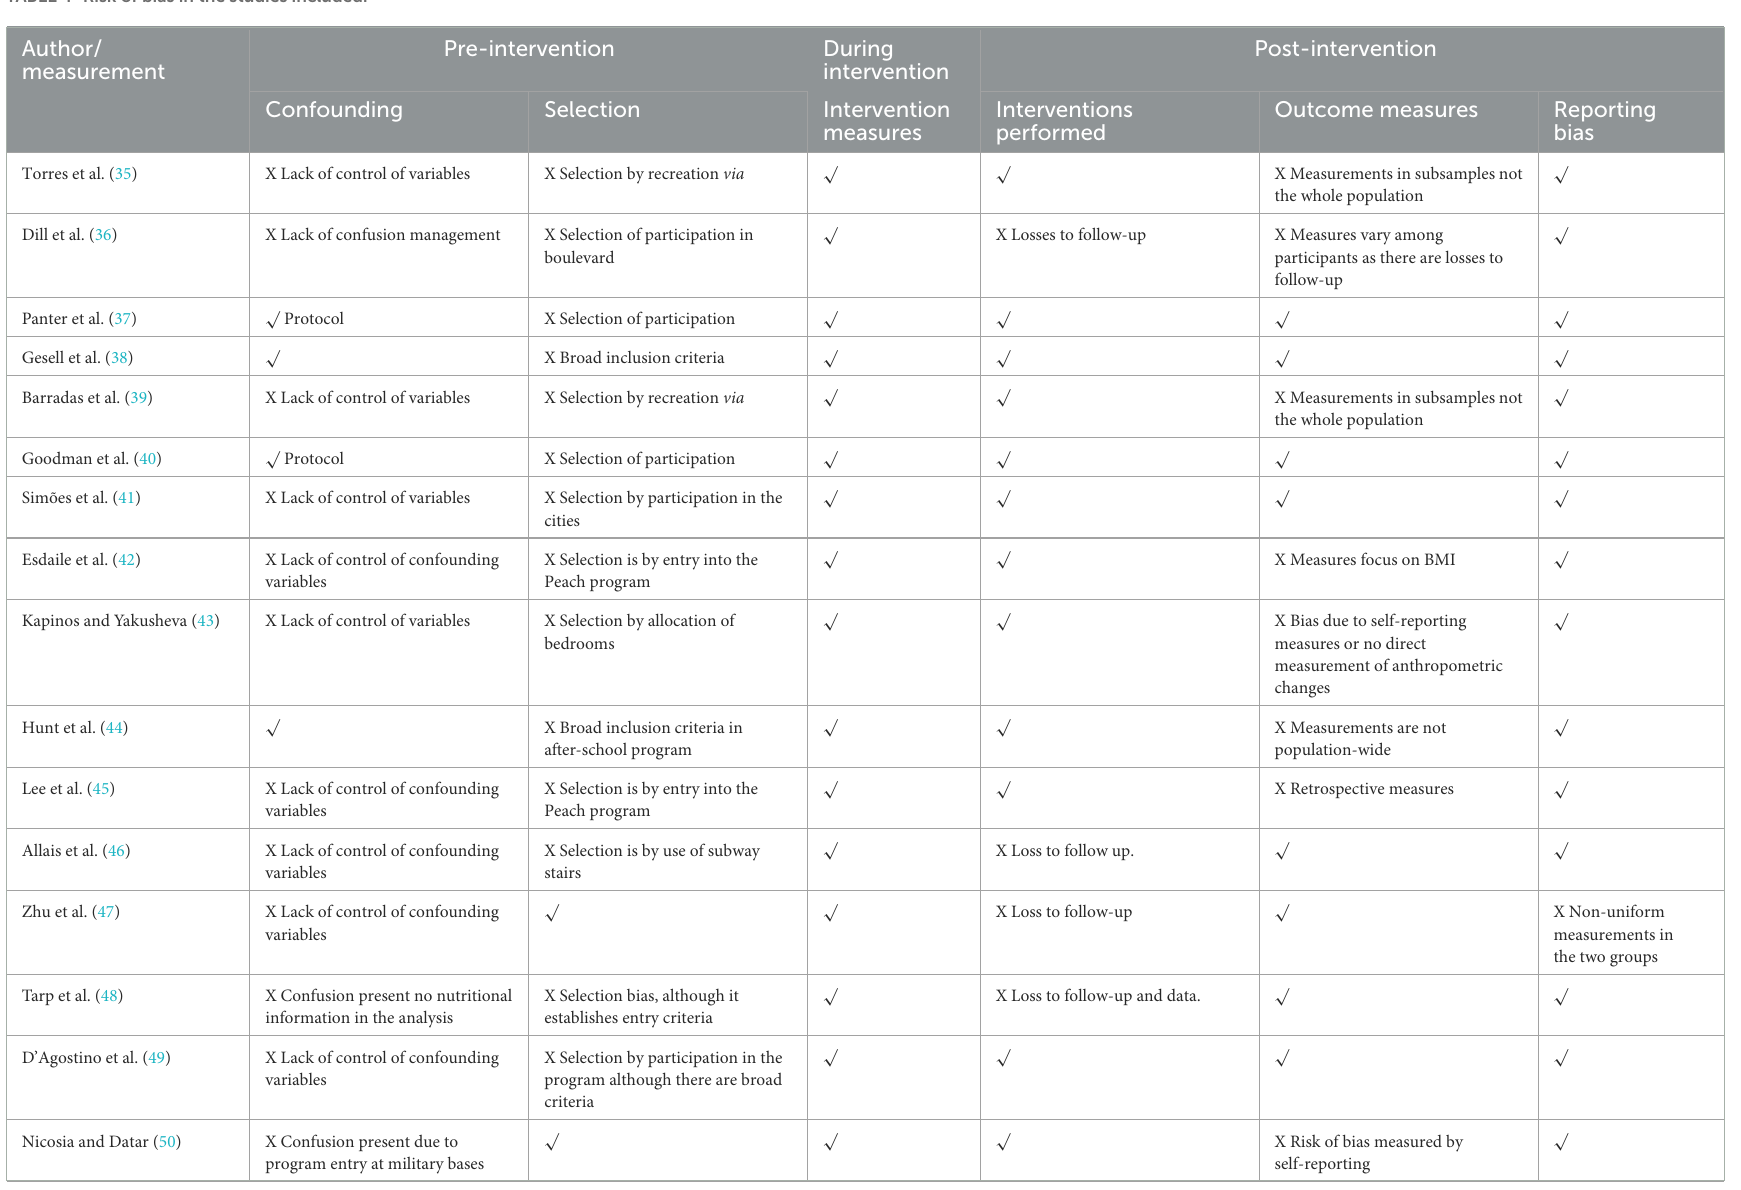
TABLE 4 Risk of bias in the studies